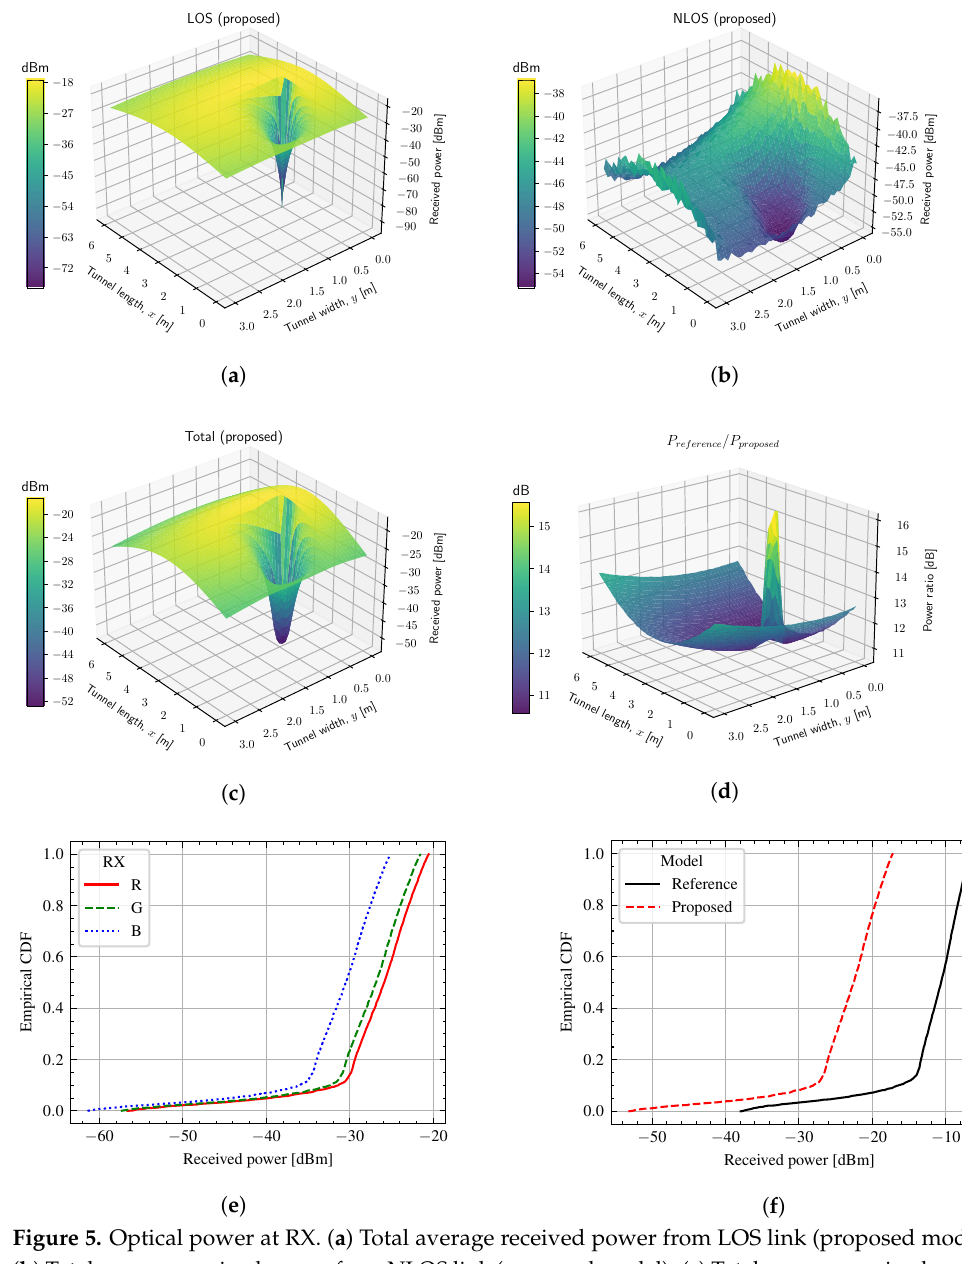
Figure 5. Optical power at RX. ( a ) Total average received power from LOS link (proposed model). ( b ) Total average received power from NLOS link (proposed model). ( c ) Total average received power (proposed model). ( d ) Ratio of total average received power between the reference model and the proposed model. ( e ) Empirical CDF for average received power at red, green, and blue PD (proposed model). ( f ) Empirical CDF for total average received power, comparison between the proposed model and reference